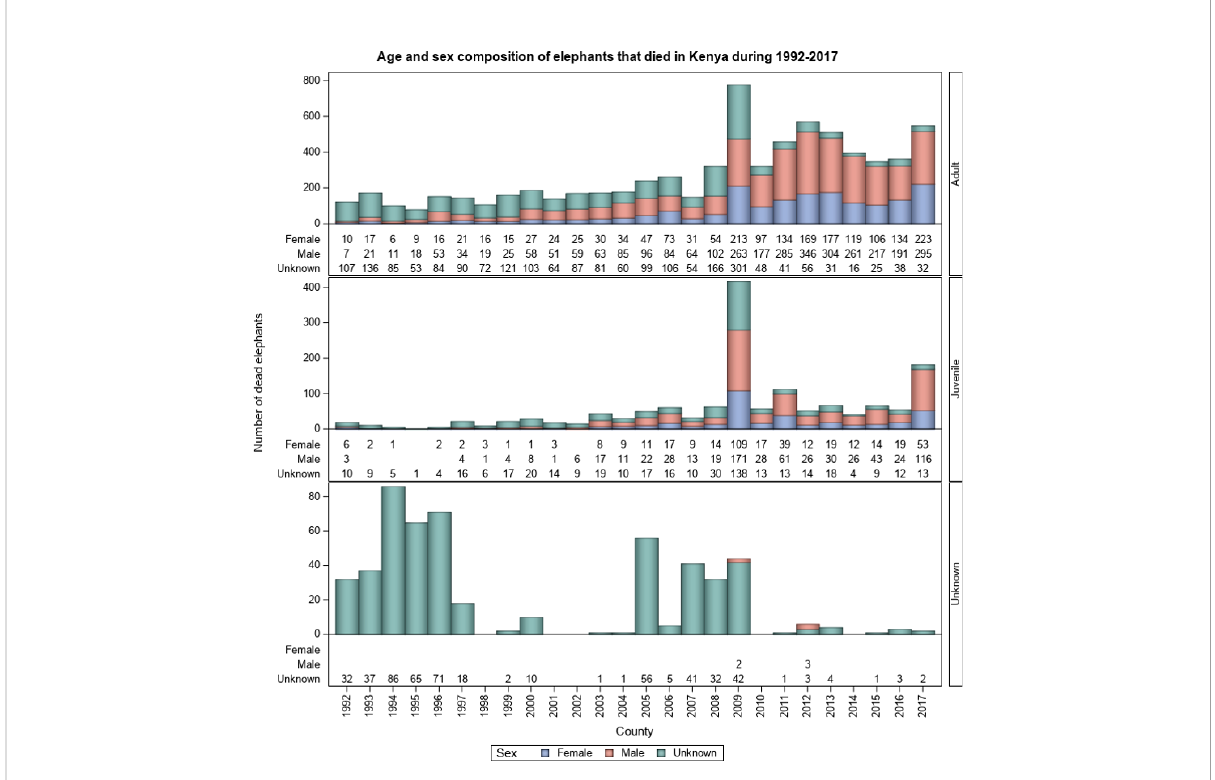
FIGURE 5 Distribution of elephant mortality by age class and sex class in Kenya during 1992-2017.